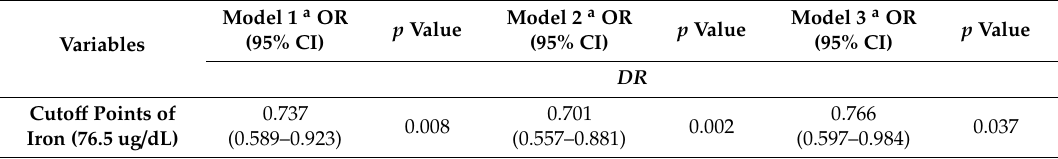
Table 6. Association between cuto ff points of iron and the presence of